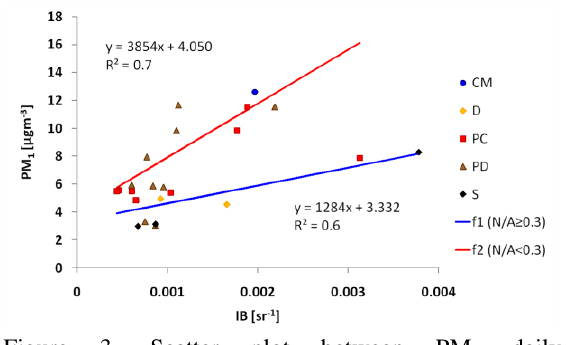
Figure 3. Scatter plot between PM 1 daily concentrations and IB values. The regression lines (f1 and f2) obtained by dividing the IB-PM 1 dataset as a function of the N/A ratio are also reported. Moreover, each IB-PM 1 couple is classified according to the corresponding CALIPSO aerosol type. Therefore, the reconstruction of the PM 1 concentrations from CALIPSO IB values was obtained as follows. If CALIPSO derived aerosol types were dust or smoke, then f1 was applied. If, or polluted continental types prevailed, a further analysis was performed. In CALIPSO IB values using both f1 and f2. If the estimated value of the PM concentration by f1 1 exceeded the value of 8.5 µgm -3 or the estimated value of the PM concentration by f2 was lower 1 than 4.5 µgm -3 , than the obtained estimate was retained. Otherwise, the PM concentrations were 1 obtained values. For clean marine cases, the same procedure used for polluted dust or polluted